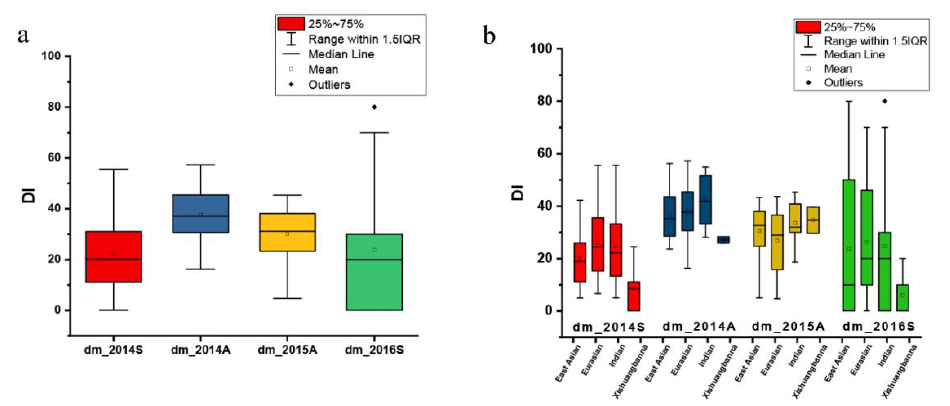
Figure 2. Box plots depicting the phenotypic distribution of disease index (DI) of downy mildew (DM) resistance in four experiments and among different ecotypes. ( a ) Phenotypic distribution in four experiments; ( b ) DI distribution in four ecotypes.